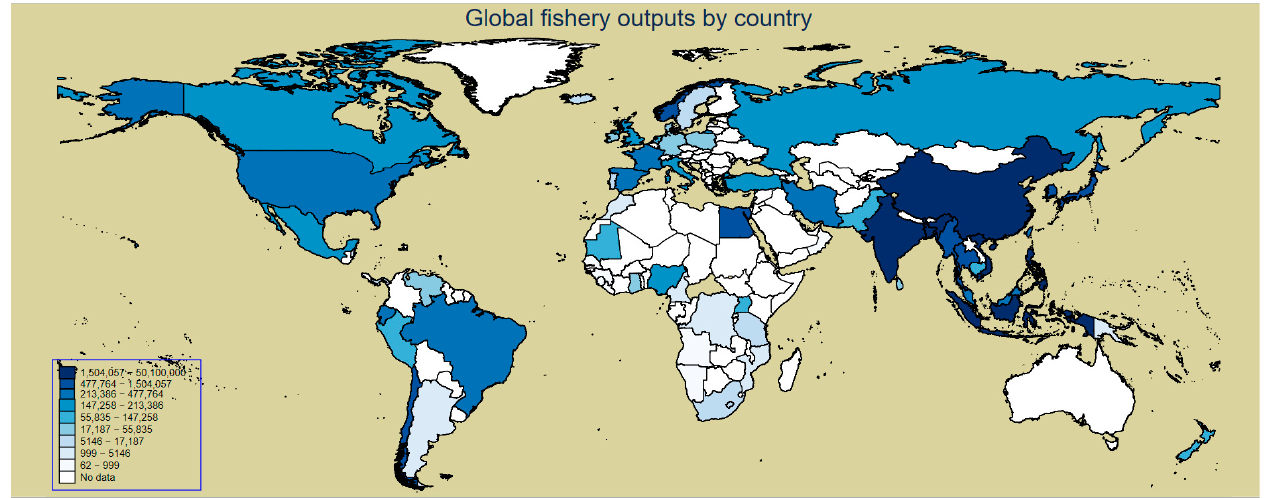
Figure 1. Geographical locations of the global fishery outputs from 2001 to 2020.